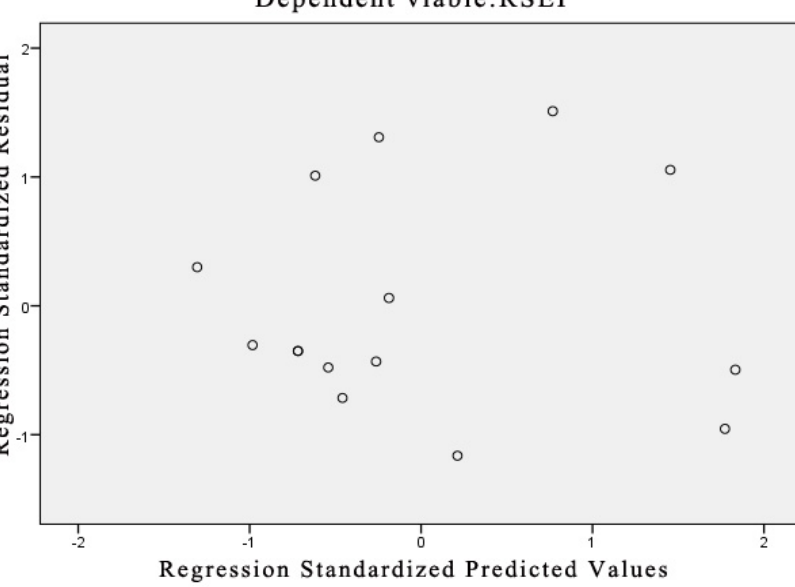
Figure 7. Change map of RSEI during 2015–2020. There were 1330 administrative village units in the study area. The number of vil- lages in the area with reduced RSEI was 205, accounting for 15.41% of the total. A total of 1125 villages exhibited improved RSEI. These villages were mostly located in the central and northern regions of Pu’an and Qinglong. The original EEQ of these regions was rela- tively low, and the effect of the upgrade in terms of RESI was obvious. The relocation of the five counties on the northeast side of the study area of Southwest Guizhou Autono- mous Prefecture, including the counties of Ceheng, Qinglong, Wangmo, Zhenfeng, and